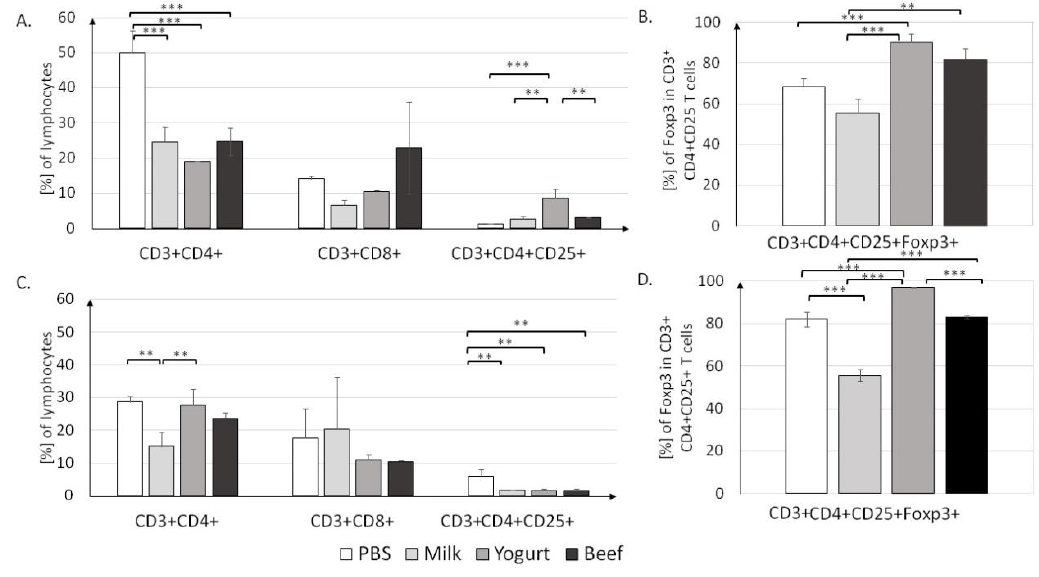
Figure 5. T cell profiles in the MLN ( A , B ) and PP ( C , D ) in mice from the PBS, Milk, Yogurt, and Beef groups. Cells were gated as follows: FSC/SSC lymphocytes were gated. Then, CD3 + and CD4 + or CD8 + cells were gated. From CD4 + CD25 + , FoxP3 + cells were gated. For each sample, 50,000 events were collected. Data are the mean ± SD. ** p < 0.01, *** p < 0.001, one-way ANOVA with Tukey post-hoc tests.